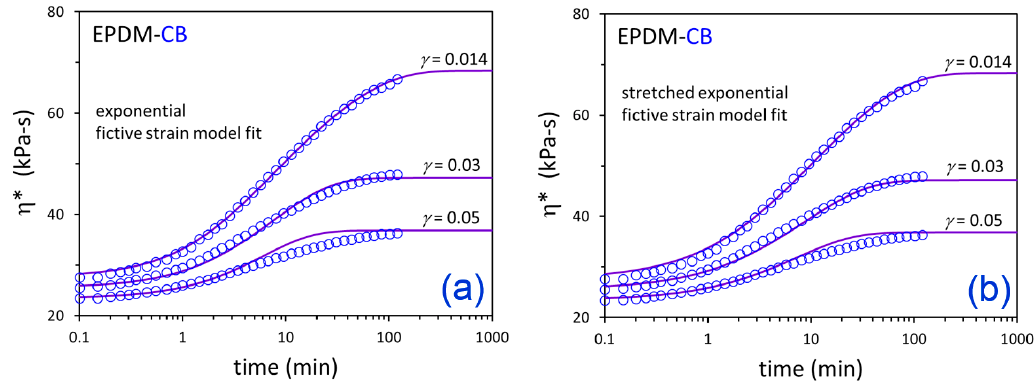
Figure 7. Time-dependent η * data (symbols) after down-jump from equilibrium at γ = 0.25 to the indicated γ values and fictive strain model fits (solid lines) for EPDM-CB using the exponential ( a ) and stretched exponential ( b ) versions of the model.